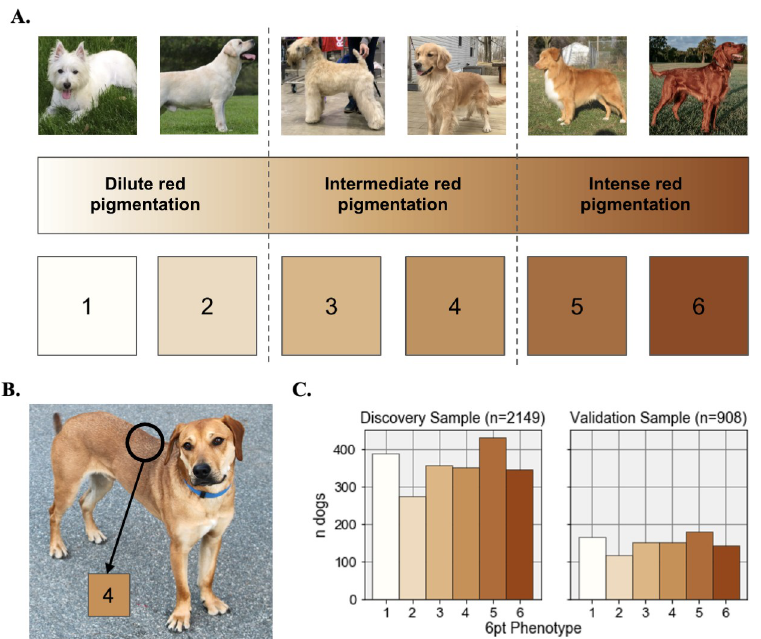
Fig 1. The six point coat pheomelanin intensity scale. A. Photos of six purebred dogs that exhibit the full range of coat pheomelanin intensity in canids are shown above a continuous color scale and numbered swatches showing the color of each of the six phenotype values used in this study. From left to right, the breeds of the dogs in these photos are: West Highland White Terrier, Yellow Labrador Retriever, Soft-coated Wheaten Terrier, Golden Retriever, Nova Scotia Duck-Tolling Retriever, Irish Setter. All six dogs pictured were part of the study sample. B. An example of a dog that displays “countershading”. The black circle indicates the part of the photo that was used to assign this dog’s phenotype (4 on the six point color scale), which in this case was the mid back. C. Histograms showing the number of dogs with each phenotype value in the discovery and validation